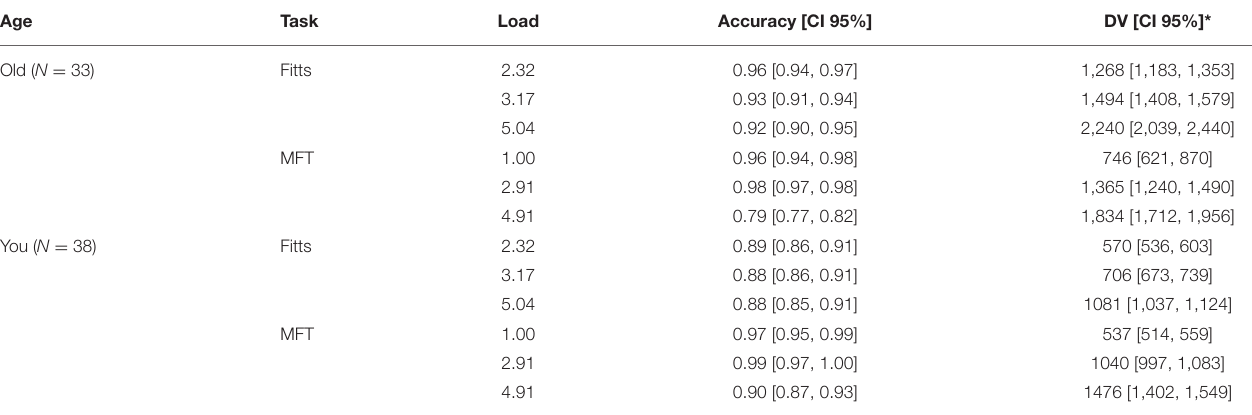
TABLE 1 | Accuracies and performance time (DV) of Fitts’ task and MFT in each combination of age, task, and load. Age Task